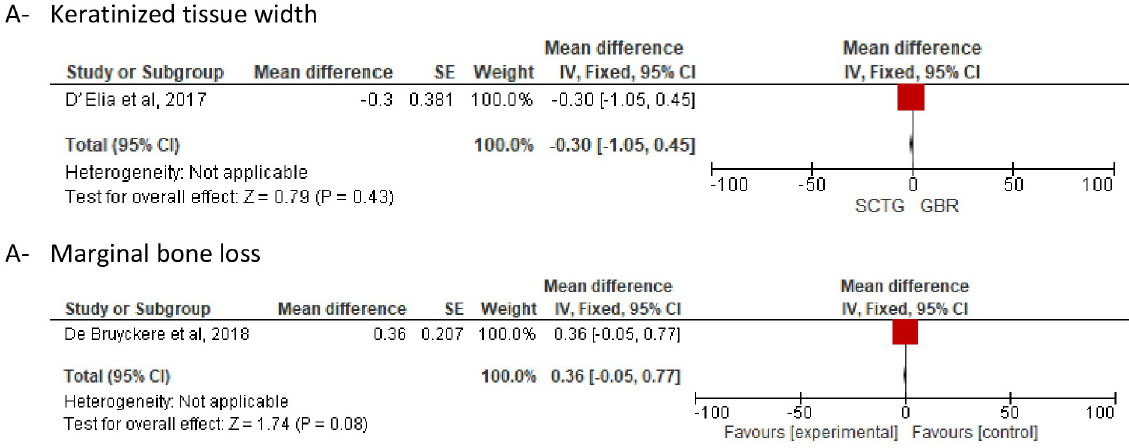
Fig 8. SCTG vs GBR along with DIP. A) Keratinized tissue width, B) Marginal bone